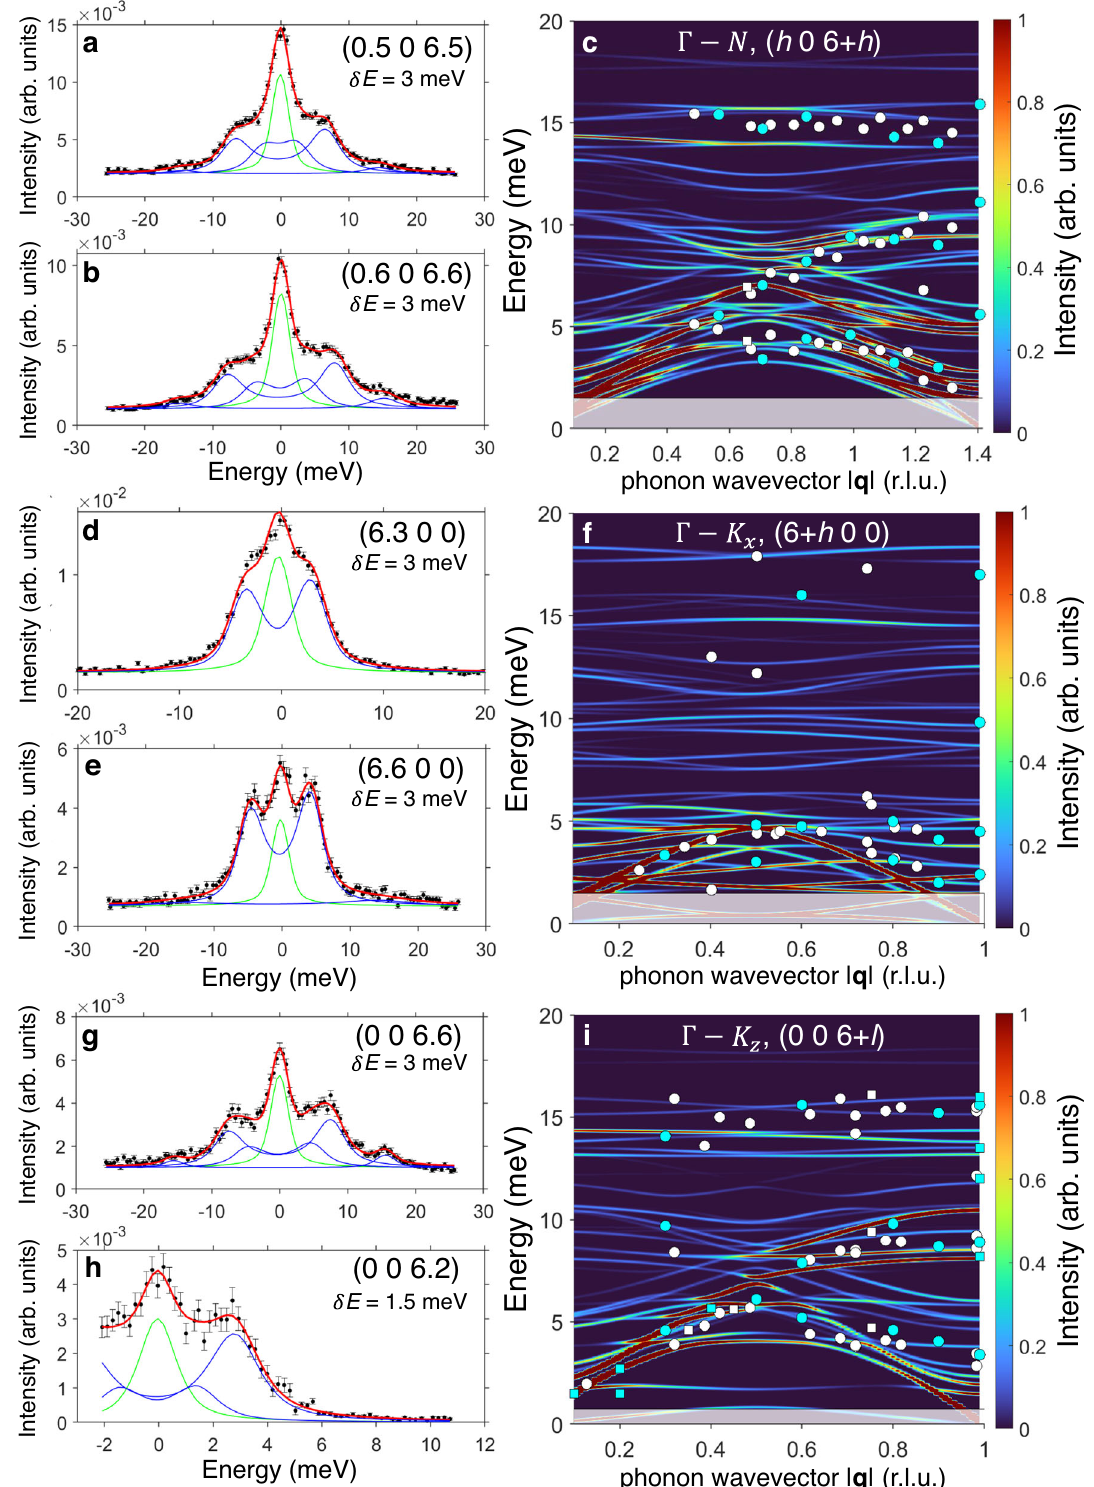
Fig. 1 | Acoustic and optical phonons up to 20 meV. ID28 data on [VO(TPP)] (black scatters, with error bars representing the SE) obtained at T = 300 K and measured with resolutions δ E =1.5,3 meV as reported on each panel. a , b Show phonon excitations along the symmetrydirection Γ – N at the (0.50 6.5)and (0.6 0 6.6) points in the reciprocal space, respectively; d , e display longitudinal phonon modes along the symmetry direction Γ – K x at the (6.3 0 0) and (6.6 0 0) points, respectively, while g , h report data of longitudinal scans along the symmetry direction Γ – K z atthe(006.6)and(006.2)points.Solidredlinesareresultsofa fi t obtained with FIT28 (see Methods), comprising the excitation signals (blue lines)